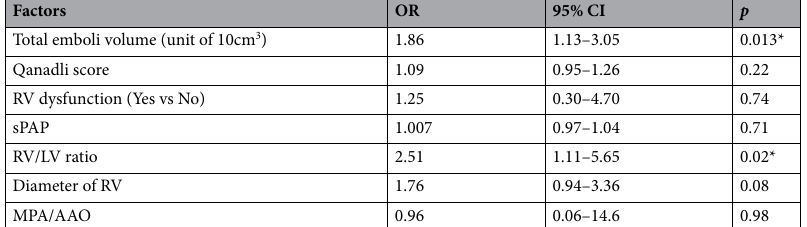
Factors OR 95% CI p Total emboli volume (unit of 10cm 3 ) Table 6. Different image modality for predicting impending shock. Shock is defined as hypotension requiring vasopressor (including dopamine, norepinephrine and vasopressin). BNP B-type natriuretic peptide, RV right ventricle, LV left ventricle, MPA diameter of main pulmonary artery, AAO ascending aorta. * The threshold for statistical significance was p < 0.05.